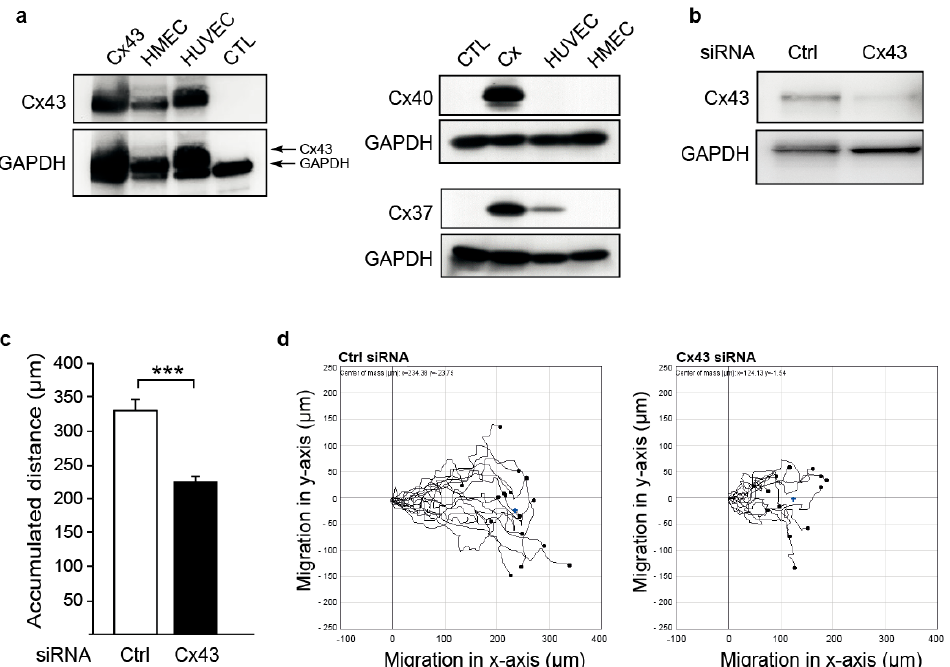
Figure 1. Downregulation of Cx43 reduces endothelial cell migration. ( a ) Western blot analysis of Cx43, Cx40, and Cx37 revealed that Cx43 is expressed in both human umbilical vein endothelial cells (HUVEC) and human microvascular endothelial cells (HMEC), whereas Cx40 and Cx37 are not expressed in HMEC. Cx43 (Cx43), Cx40 (Cx), and Cx37 (Cx) expressing HeLa cells were used as the positive controls. CTL: Wildtype HeLa cell lysate. ( b ) Western blot analysis of Cx43 in HMEC transfected with 100 nM siRNA against Cx43 or non-silencing control siRNA (Ctrl) for 48 h. The Cx43 expression was analysed using a polyclonal Cx43 antibody. Immunostaining for GAPDH was used as the loading control. ( c ) Serum-induced cell migration of HMEC transfected with a Cx43-siRNA or a control siRNA (Ctrl) in response to 10% FCS was assessed in a wound assay. Downregulation of Cx43 significantly decreased cell migration, represented as accumulated distance (*** p < 0.001 Ctrl-siRNA vs. Cx43-siRNA, n = 6, 3 independent cell cultures). ( d ) Representative single cell traces of migrated HMEC.